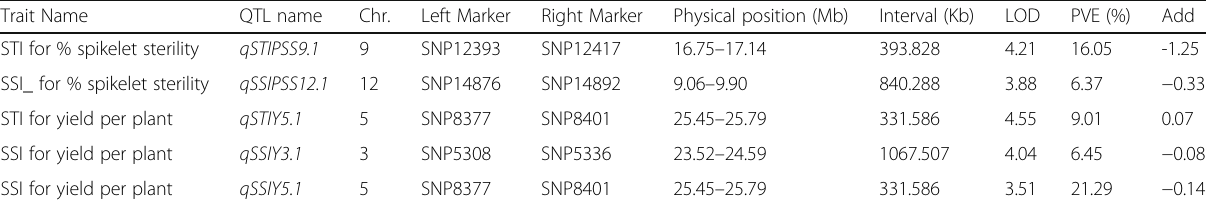
Table 4 QTLs for heat stress indices identified in RIL mapping population derived from N22 and